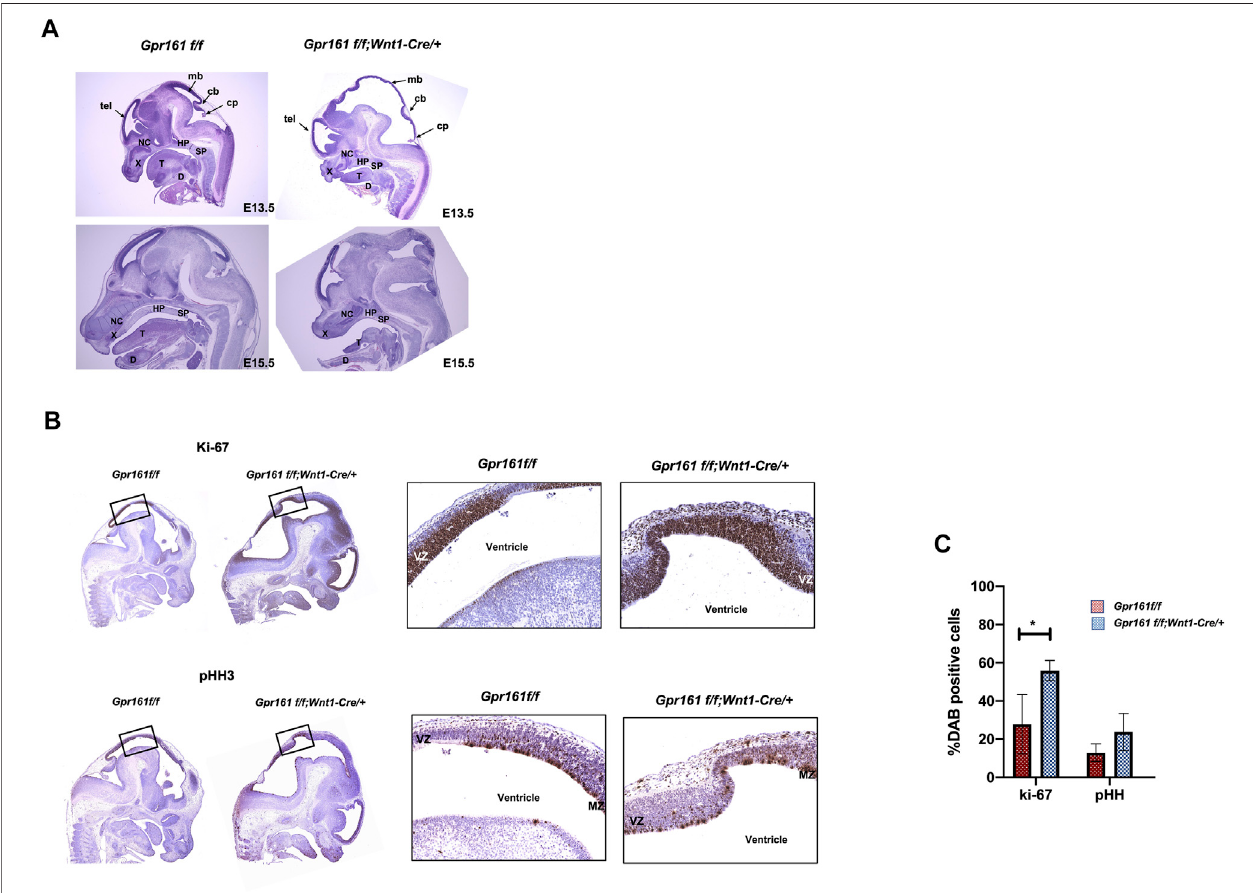
FIGURE 2 | Histological analysis and IHC demonstrating the increased cellular proliferation in the midbrain of Gpr161 cKO fetuses. (A) H&E staining of Gpr161 f/f and Gpr161 f/f ;Wnt1-Cre/+ at E13.5 (n (cid:1) 3) and E15.5 (n (cid:1) 3); cb, cerebellum; cp, choroid plexus; D, mandible; HP, hard palate; mb, midbrain; NC, nasal cavity; SP, soft palate; T, tongue; tel, telecephalon; X, maxilla (B) IHC with Ki-67 and pHH3 antibodies in midbrain sections of Gpr161 f/f and Gpr161 f/f ;Wnt1-Cre/+ at E13.5 (n (cid:1) 3). The black boxes indicate the areas magni fi ed in the right panel. VZ: ventricular zone, MZ: mitotic zone (C) The statistical analysis of IHC with Ki-67 and pHH3 shown in (B) . Y axis indicates the percentage of neurons that were Ki-67, pHH3, and Gli1 positive. The experiments were done triplicate and values were shown as means and standard deviations (SD). The statistical analysis was performed using a 2-way ANOVA, followed by Tukey ’ s test for multiple comparison (GraphPad Prism